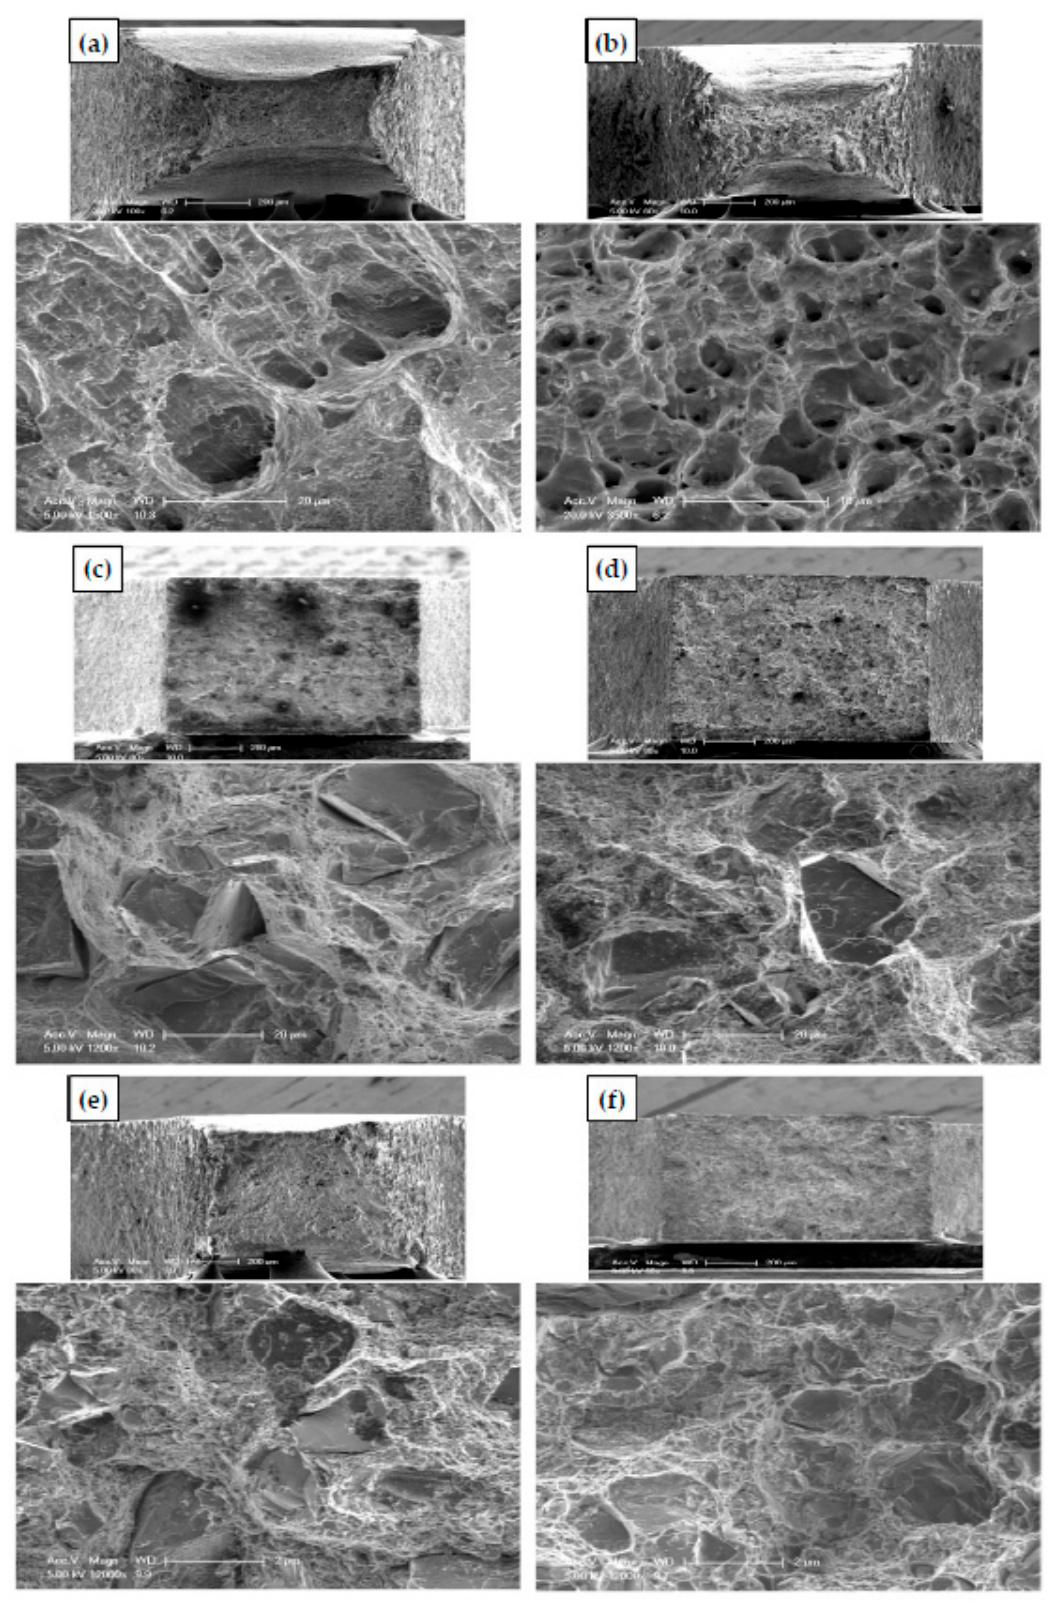
Figure 10. Fracture mode and surface morphology of ( a ) PM Al, ( b ) HPT Al, ( c ) PM Al-20% Al 2 O 3 , ( d ) PM-20% SiC, ( e ) HPT Al-20% Al 2 O 3 , and ( f ) HPT Al-20% SiC